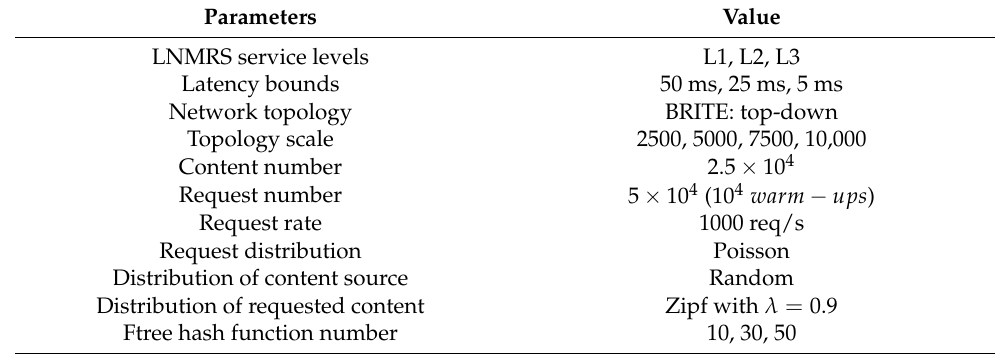
Table 3. Summary of